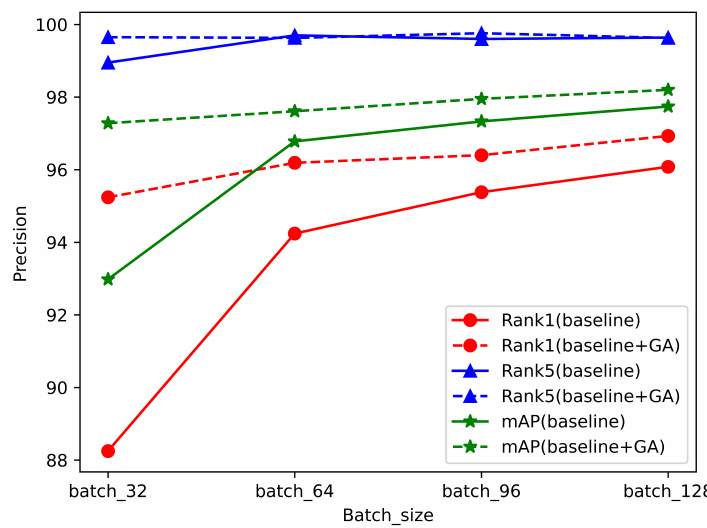
Figure 9. The results of the ablation experiment for